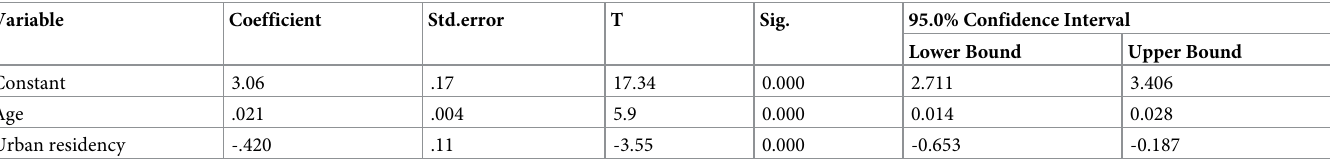
Table 7. Multiple linear regression of CBD diameter with age and residency, Northwest Ethiopia,